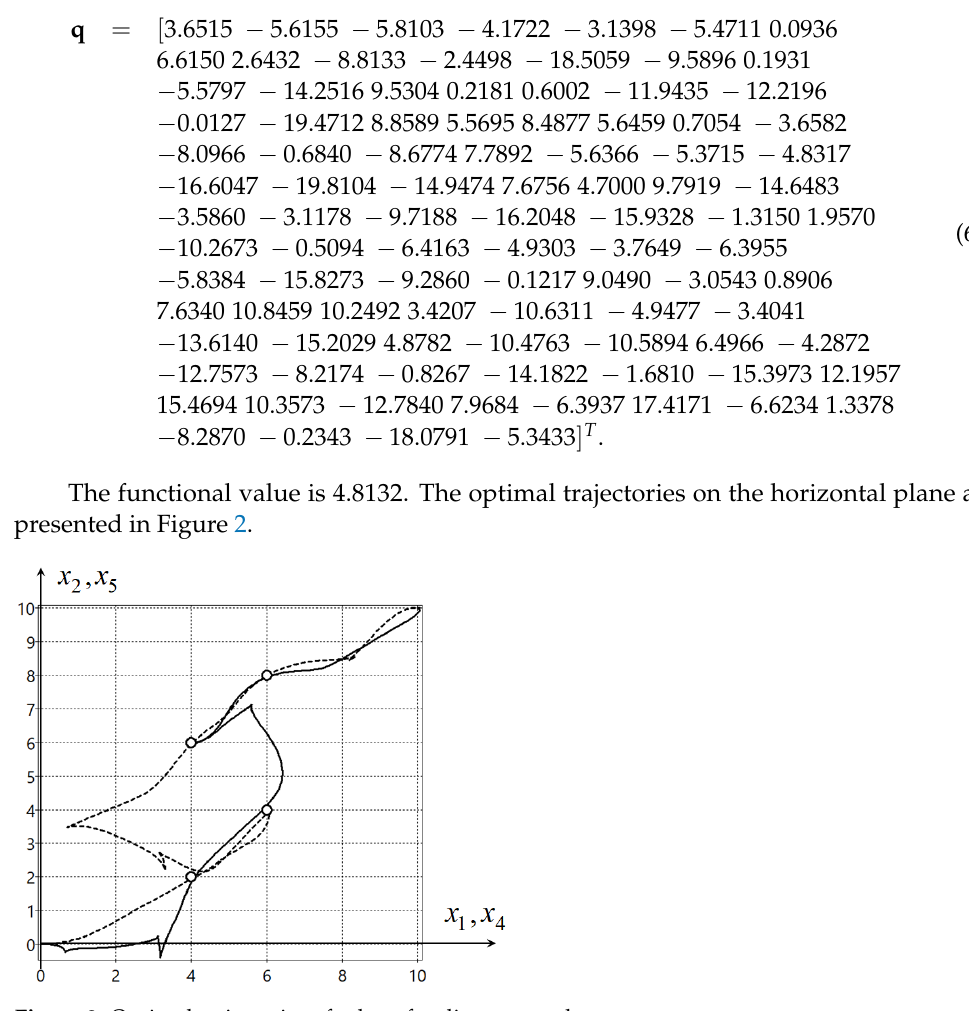
Figure 2. Optimal trajectories of robots for direct